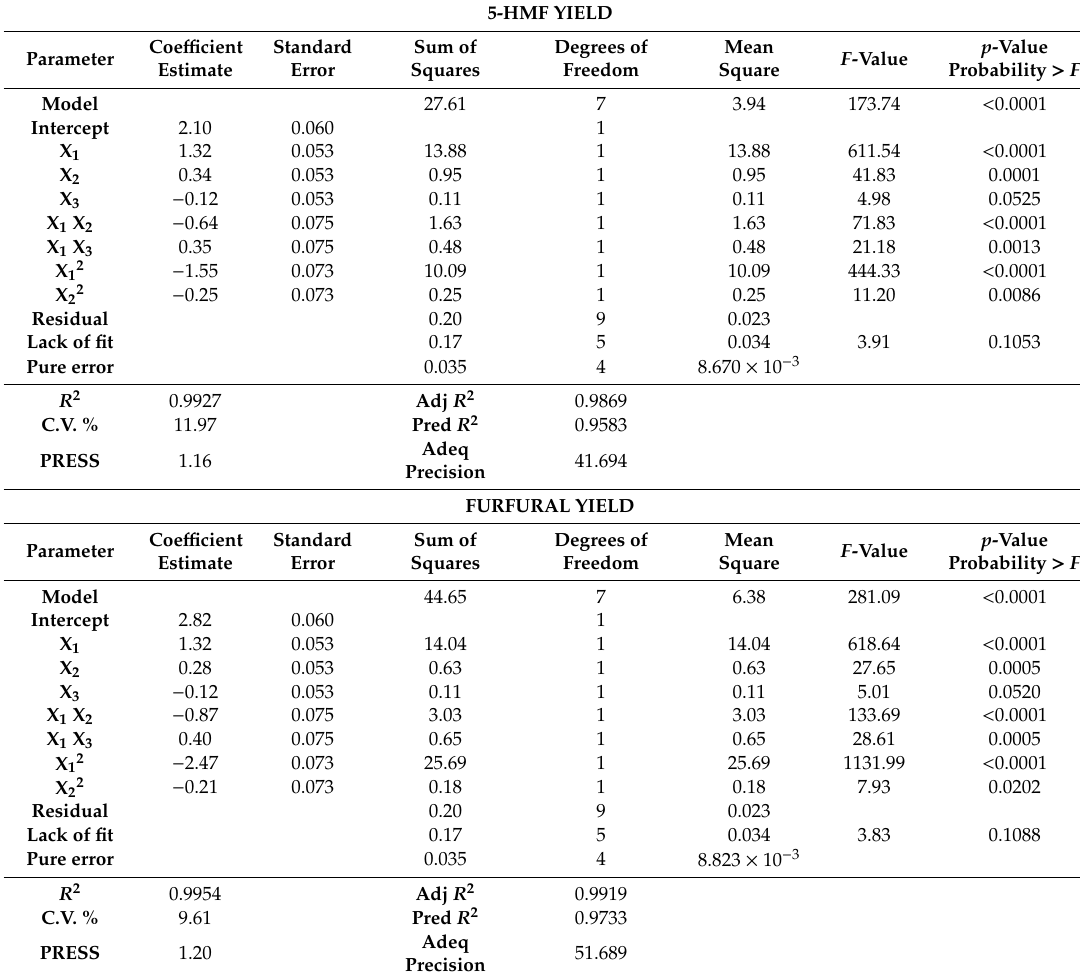
Table 11. The values of regression coe ffi cients and analysis of the models for 5-HMF and furfural